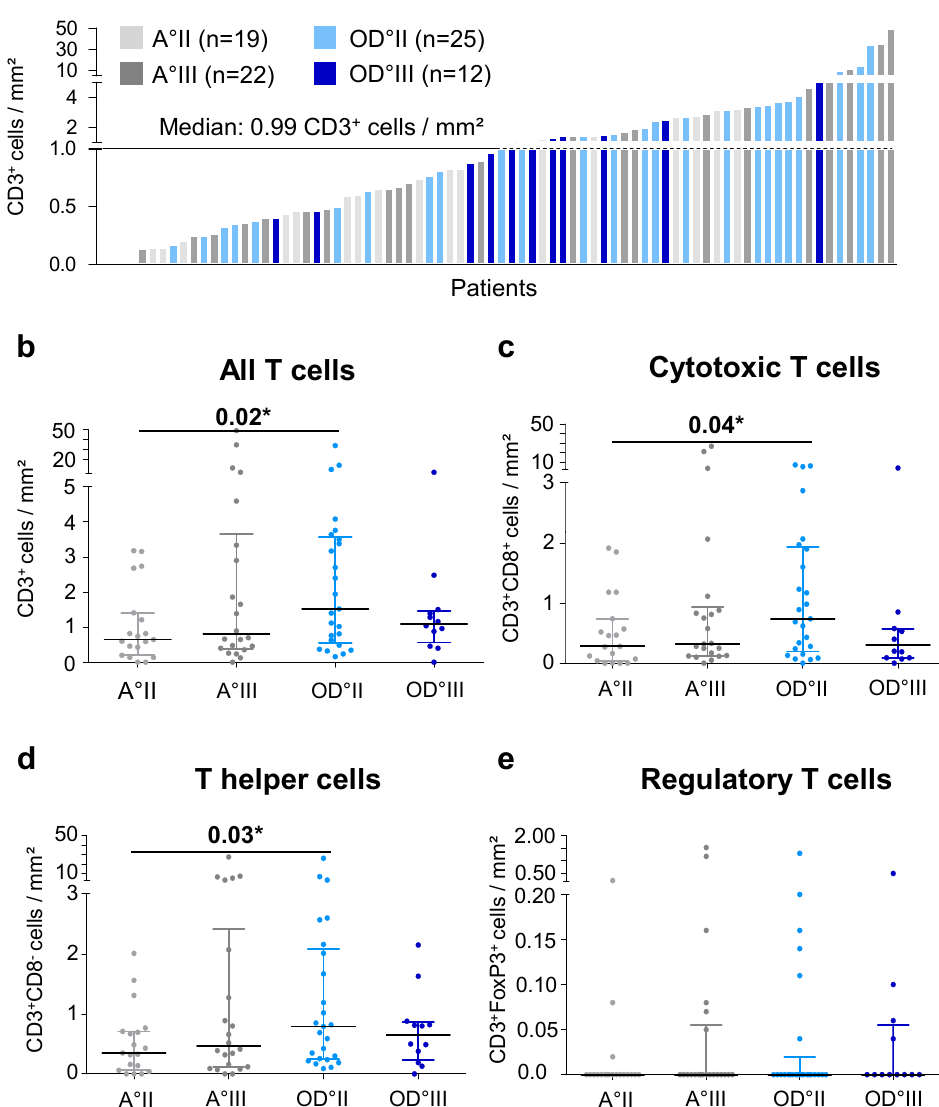
Figure 2. T cell infiltration in primary IDH mut glioma: ( a ) distribution of T cell infiltration normalized to the area analyzed and color-coded for glioma subtype and WHO grade and ( b − e ) analysis of T cell infiltration in astrocytoma and oligodendroglioma categorized by their WHO grade for ( b ) all T cells, ( c ) cytotoxic T cells, ( d ) T helper cells, and ( e ) regulatory T cells. A, astrocytoma; OD, oligodendroglioma; mm 2 , square millimeter; II, WHO grade II; III, WHO grade III; * p <